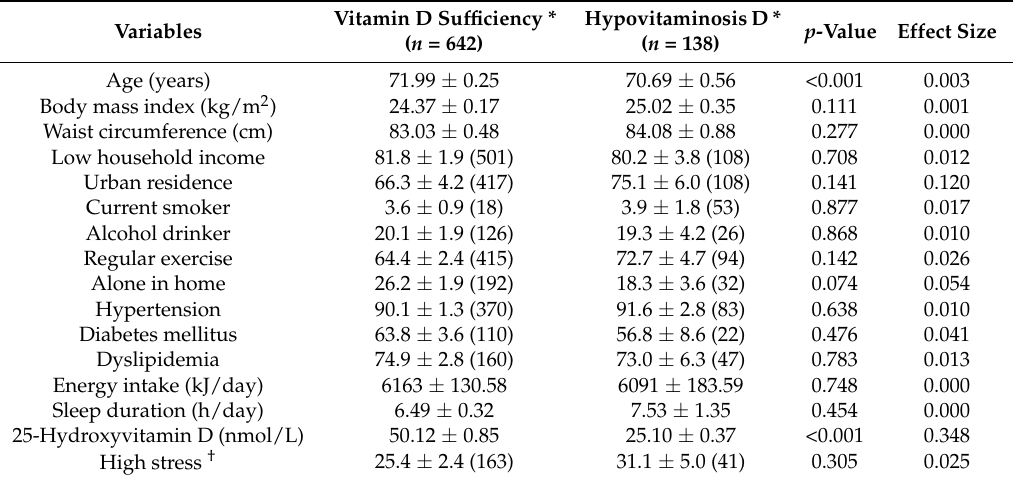
Table 3. General characteristics of women according to vitamin D